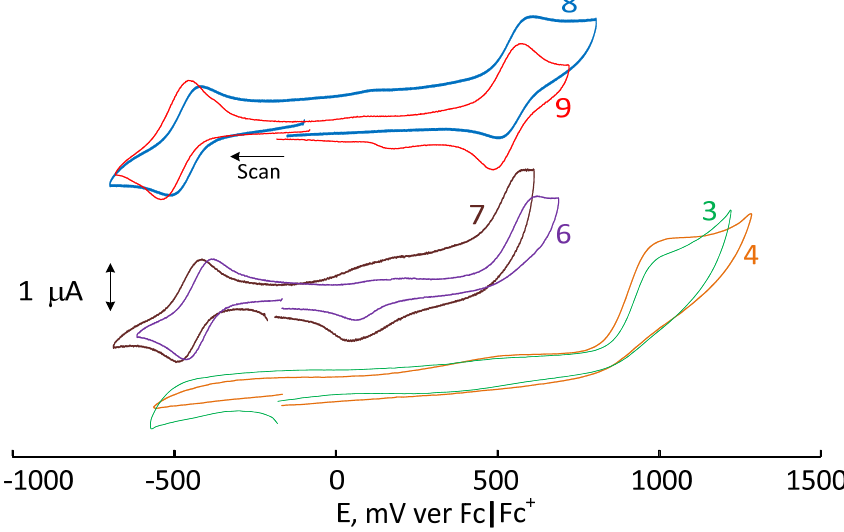
Figure 6. CVA curves for ruthenacarboranes in 1,2-dichloroethane ( С = 3 × 10 − 3 М ) at 25 °C. Supporting electrolyte n -Bu 4 NPF 6 (0.2 M). Scan rate 100 mV/s. Supporting electrolyte n -Bu 4 NPF 6 (0.2 M). Scan rate 100